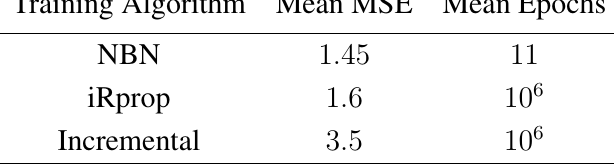
Table 2. Performance of different neural network training